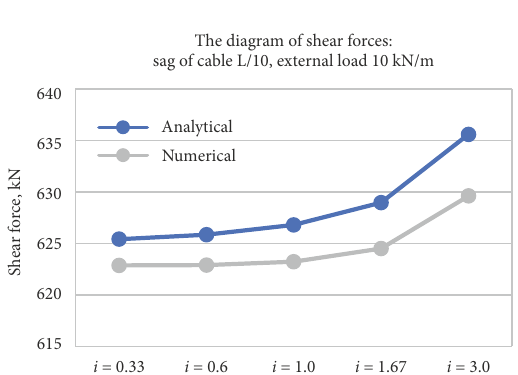
Figure 6. The diagram of shear forces, in case the load is transferred to the struts, the string is not